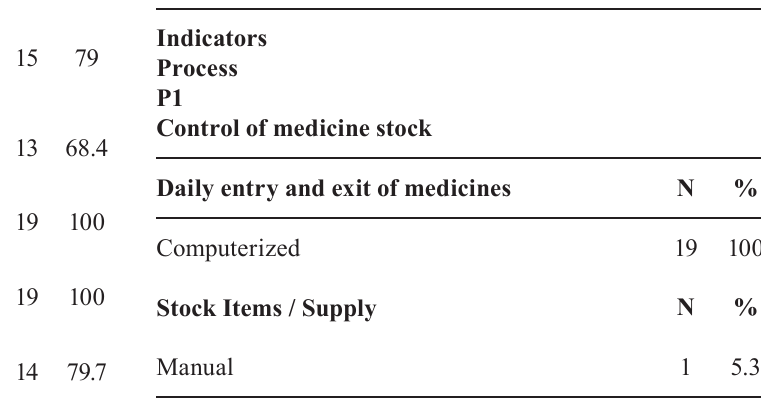
TABLE II - Process indicators (P1 and P2) of PS in PHC, in 2015 and